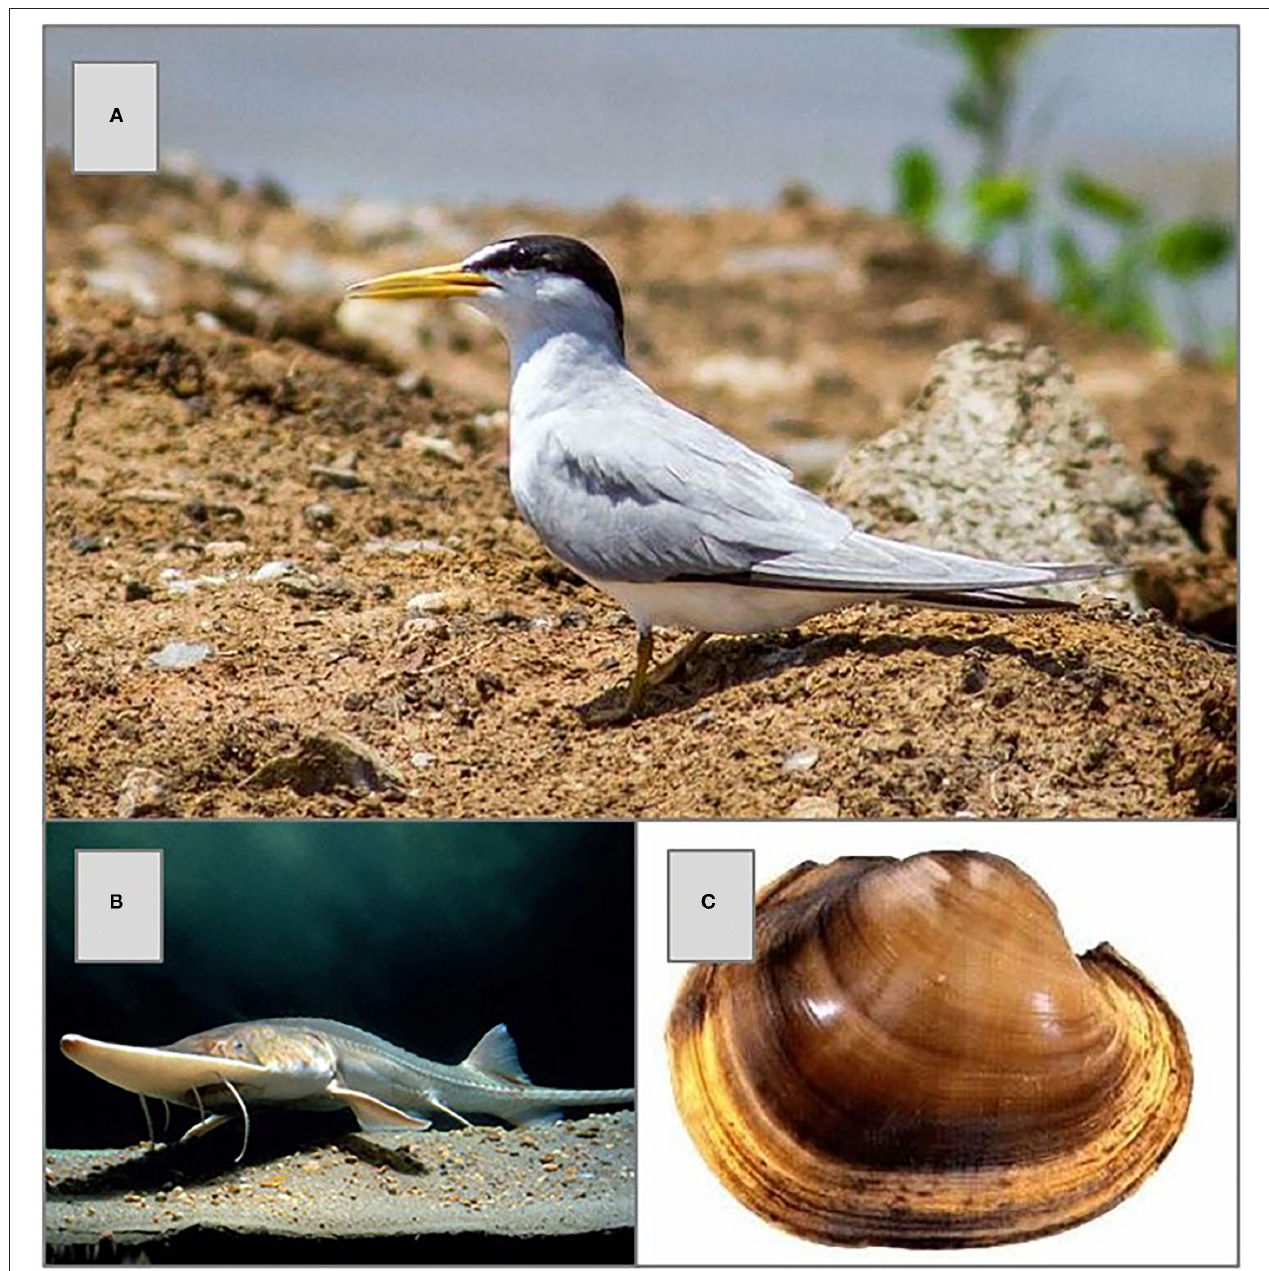
FIGURE 1 | The three endangered species covered by the USACE 7(a)(1) Conservation Plan for the lower Mississippi River. These species are (A) the interior least tern ( Sternula antillarum ; credit: USFWS), (B) the pallid sturgeon ( Scaphirhynchus albus ; credit: USFWS), and (C) the fat pocketbook mussel ( Potamilus capax ; credit: